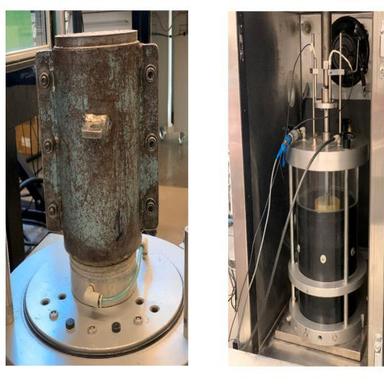
(a) Split cylinder mould and (b) Sample for testing in triaxial repeated load machine.